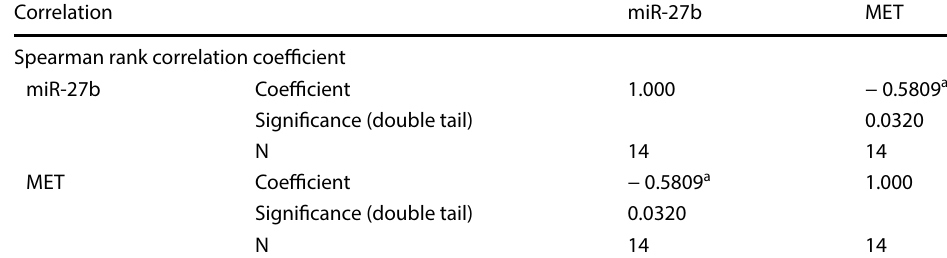
Table 2 Rank correlation coefficient statistics of